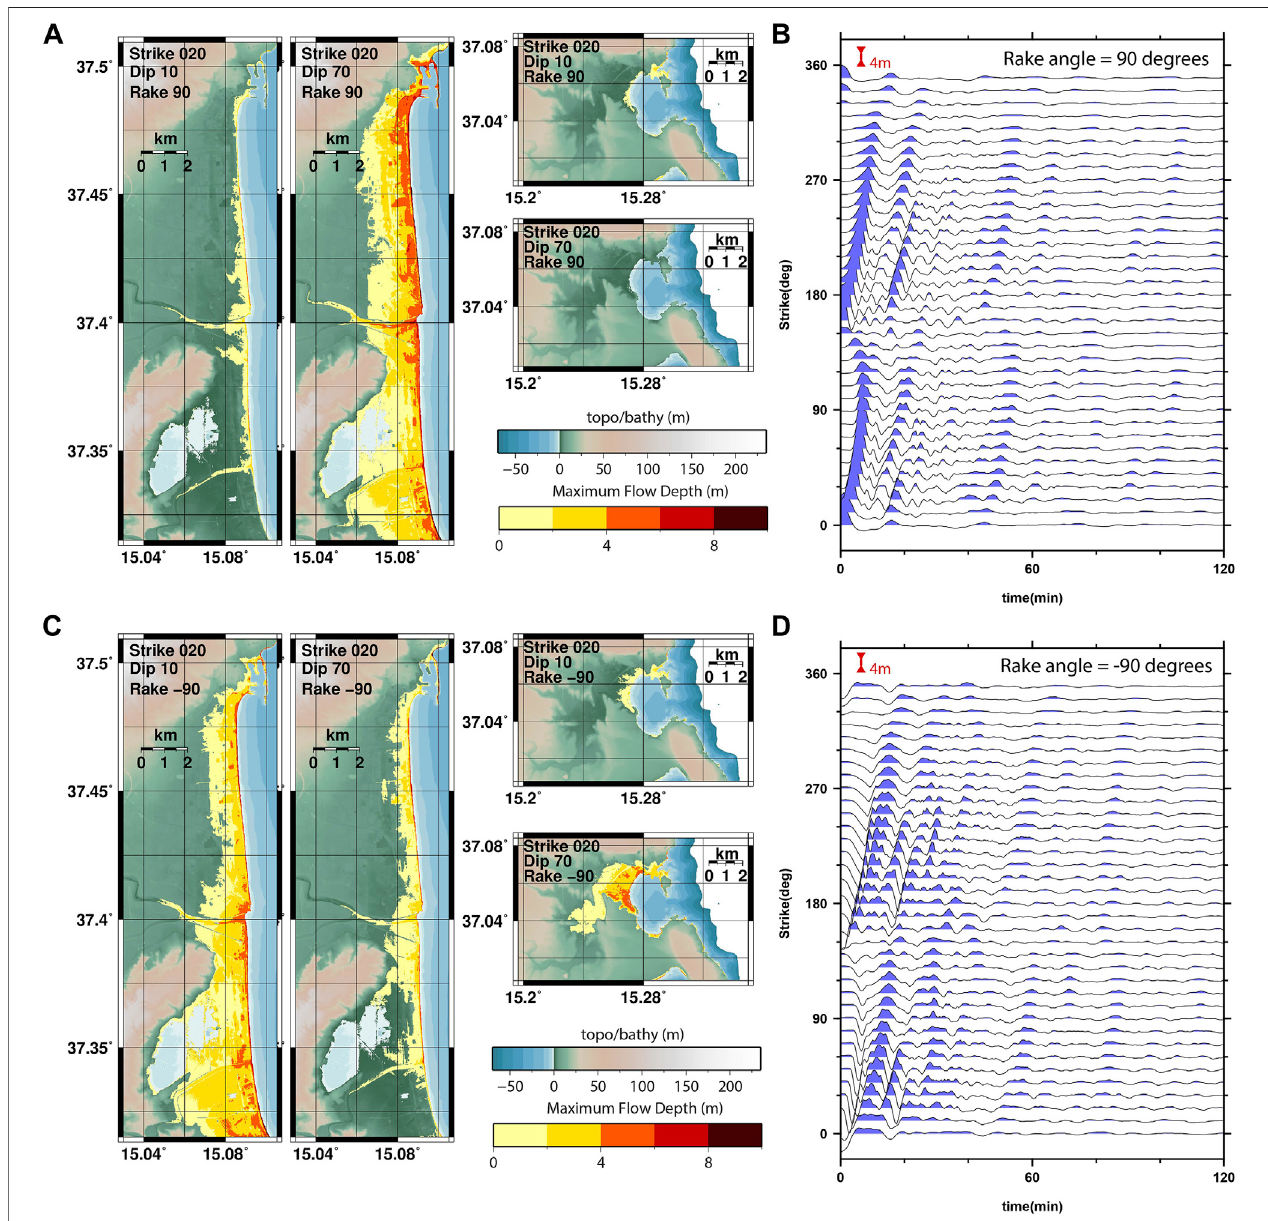
FIGURE 11 | Inundation maps for Catania and Siracusa for the relatively distant offshore earthquakes as indicated together with surface elevation time-series as simulatedatthelocation37.5368 o N,15.1333 o E.Panels (A,B) displayinundationmapsandwaveheightforrake (cid:1) 90 o ,panels (C,D) forrake (cid:1) − 90 o .Thetime-seriesare all for the dip (cid:1) 50 o scenarios. Vertical surface elevation scales and colour scales are identical for all panels.